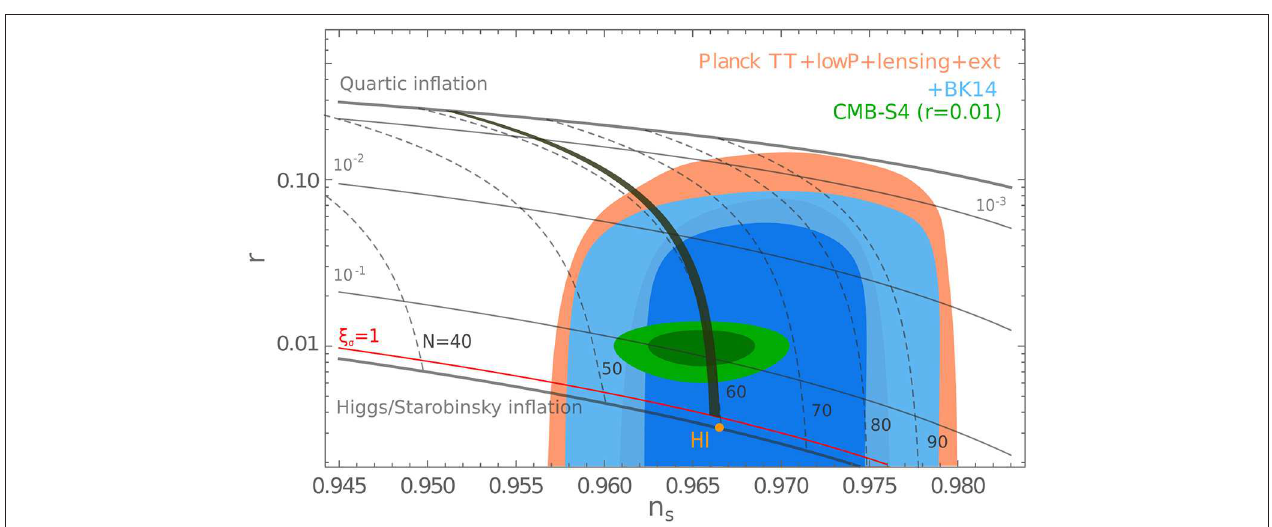
FIGURE 5 | Predictions for the potential of Equation (30) in the r vs. n s plane with a pivot scale of 0.002 Mpc − 1 [adapted and used with permission from Ballesteros et al. (2017b)]. Contours of constant ξ σ are shown as black solid lines. The SMASH prediction accounting for a consistent reheating history is given by the thick black line, while the thin dotted lines give isocontours of the number of e-folds that ignore reheating constraints. Also shown are the 68 and 95% C.L. regions at 0.002 Mpc − 1 of Ade et al. (2016b) and the projected sensitivity of CMB-S4 (Abazajian, 2016) (in green). The line labeled as “Quartic inflation” shows the prediction for a quartic potential (corresponding to the limit ξ σ 0), while we also show a black solid line corresponding to the limit ξ σ , in which the dynamics is analogous to → → ∞ that in the Starobinsky (Starobinsky, 1980) and Higgs inflation (HI) (Bezrukov and Shaposhnikov, 2008) models. The HI result of Gorbunov and Tokareva (2013) is indicated as a point on this